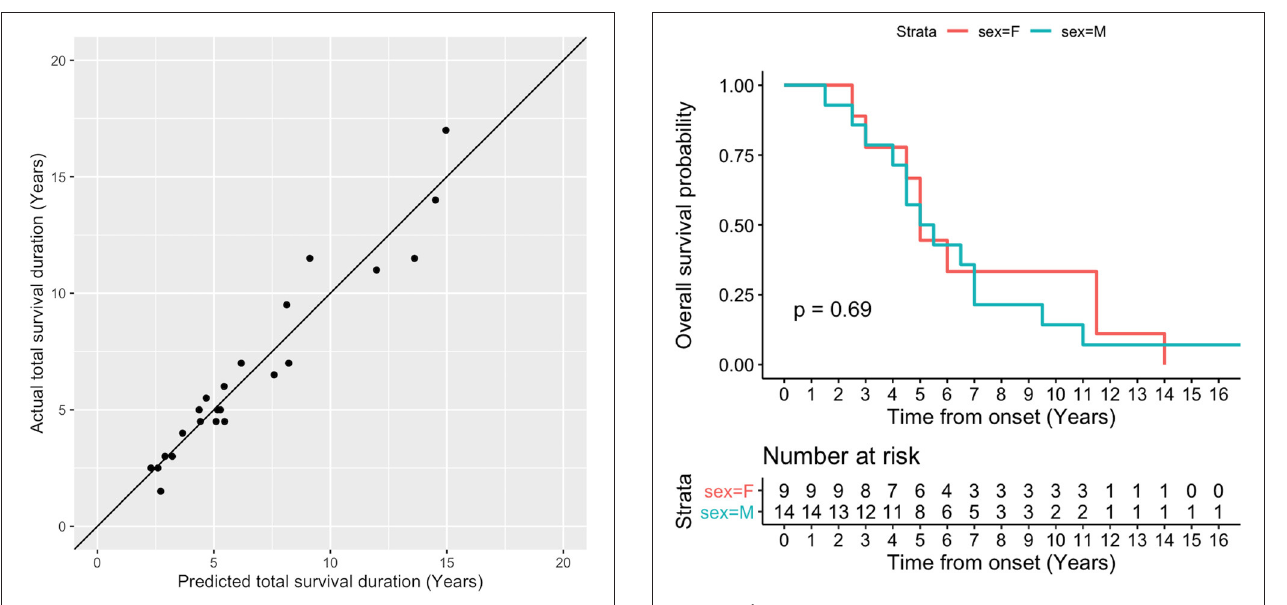
FIGURE 3 | An accurate prediction of the total survival duration by using the equation compared to the actual values of the total survival duration. Each dot (formed by the predicted value in the x -axis and actual value in the y -axis) should be on the 45-degree diagonal line if the predicted value is equal to the actual value in the total survival year, which is virtually the case.